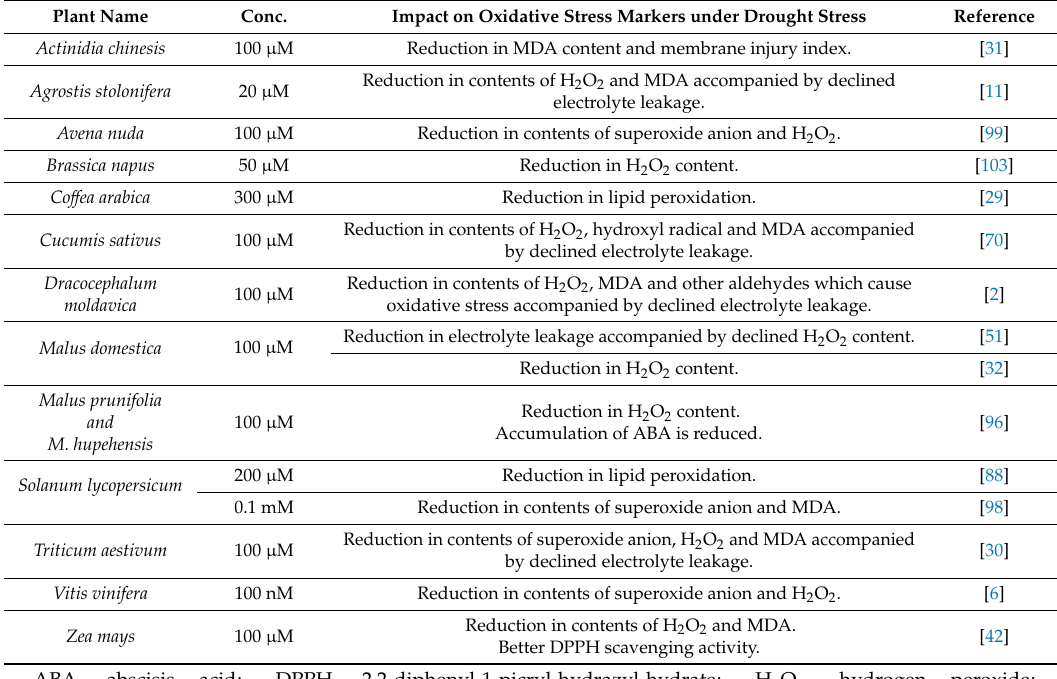
Table 2. Summary table explaining the e ff ect of exogenous applied melatonin on various oxidative stress markers under drought